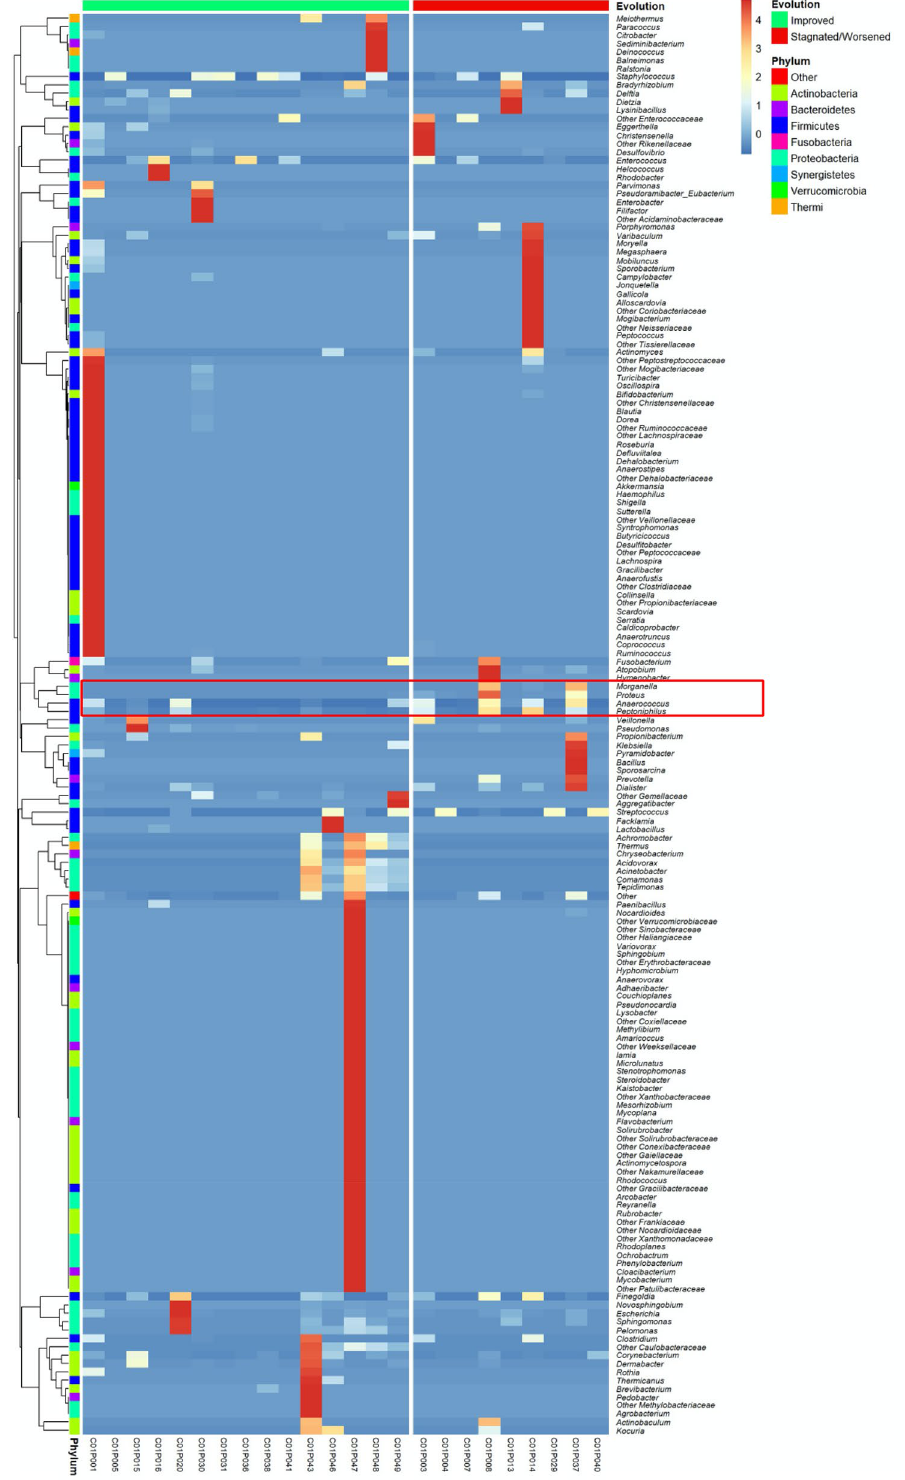
Figure 4. Heatmap of the PU microbiota’s standardised composition at D28 ranked according to wound evolution. Standardised relative frequencies of genus are used to see variations between groups even for low- abundant bacteria. Genera are classified according to agglomerative hierarchical clustering with complete